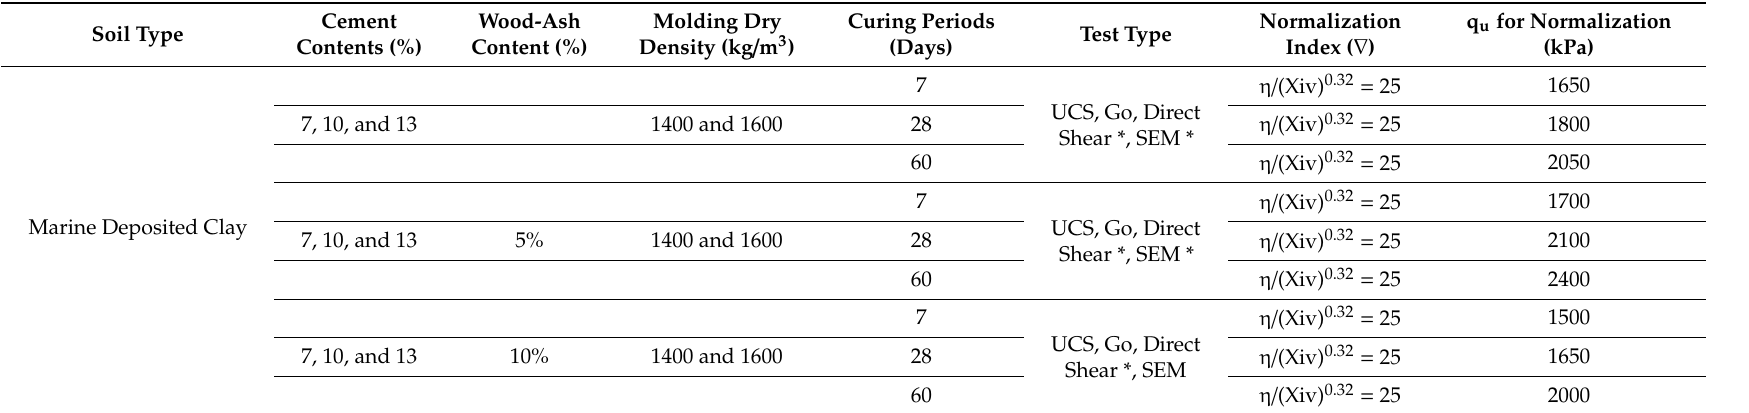
Table 3. Details of molding, curing, and normalization parameters of all